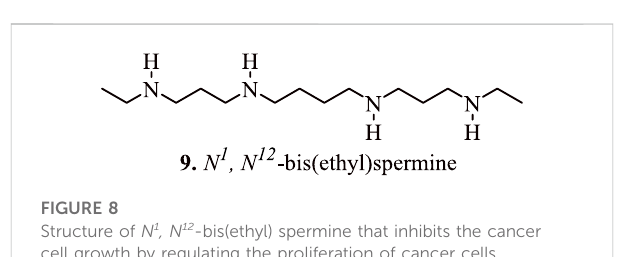
FIGURE 8 Structure of N 1 , N 12 -bis(ethyl) spermine that inhibits the cancer cell growth by regulating the proliferation of cancer